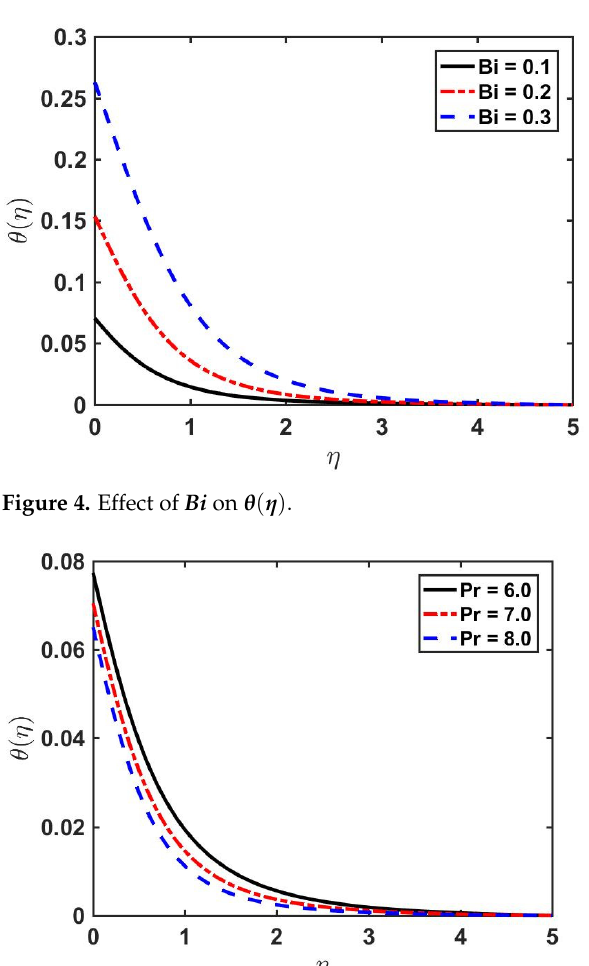
10 of 18 Figure 3. Effect of 𝑲 on ( a ) 𝒇′(𝜼) , ( b ) 𝑷(𝜼) , and ( c ) 𝜽(𝜼) . Figure 3a–c illustrate the effects of curvature 𝐾 on 𝑓 (cid:4593) (𝜂) , 𝑃(𝜂) , and 𝜃(𝜂) . It is evi- dent from Figure 3a,b that the value of 𝑓 (cid:4593) (𝜂) and 𝑃(𝜂) increases with an enhancement in the value of the curvature parameter. Figure 3c portrays the effect of curvature 𝐾 on the distribution of heat 𝜃(𝜂) . By raising the value of the curvature factor, the graph shows a reduction in the value of heat distribution. As we increase 𝐾 , the flatness of the stretching surface increases. Due to an increase in the flatness of the stretching surface, the flow velocity increases, and the temperature profile decreases because the resistance between the layers of the fluid reduces. Figure 4 shows the impact of 𝐵𝑖 on heat distribution. As we increase the value of the Biot number, there is a certain rise in the temperature profile because the Biot num- ber is a relation within the internal conductive resistance to the surface offered convec- tive resistance. It means that as we increase the Biot number, the internal conductive re- sistance increases, making the cross-boundary layer thickness stronger. Figure 5 shows